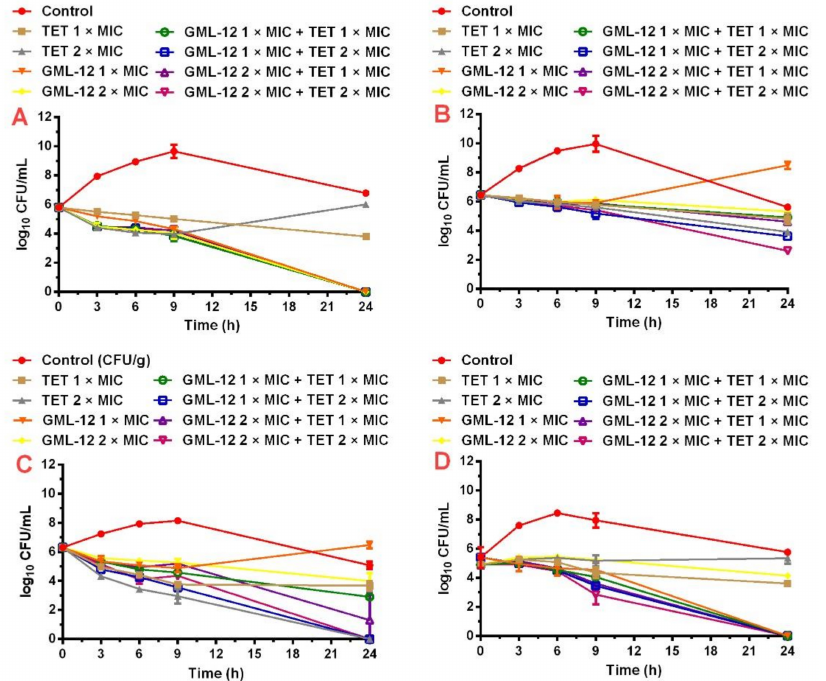
Figure 1. Time-kill curves of TET and GML-12 alone and in combination against ATCC 43,765 ( A ), S40 ( B ), SNJ-5 ( C ) and S11 ( D ). The mean of three biological replicates is shown and error bars represent the